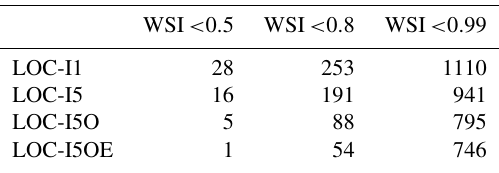
Table 9. Numbers of grid cells below the WSI